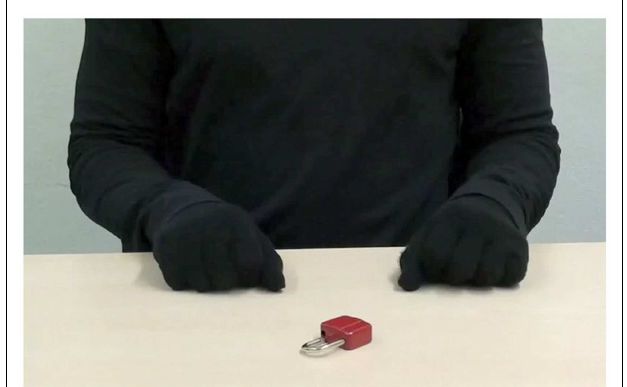
FIGURE 2 | Screenshot of action video Unlock the lock! presented in the out-group condition.